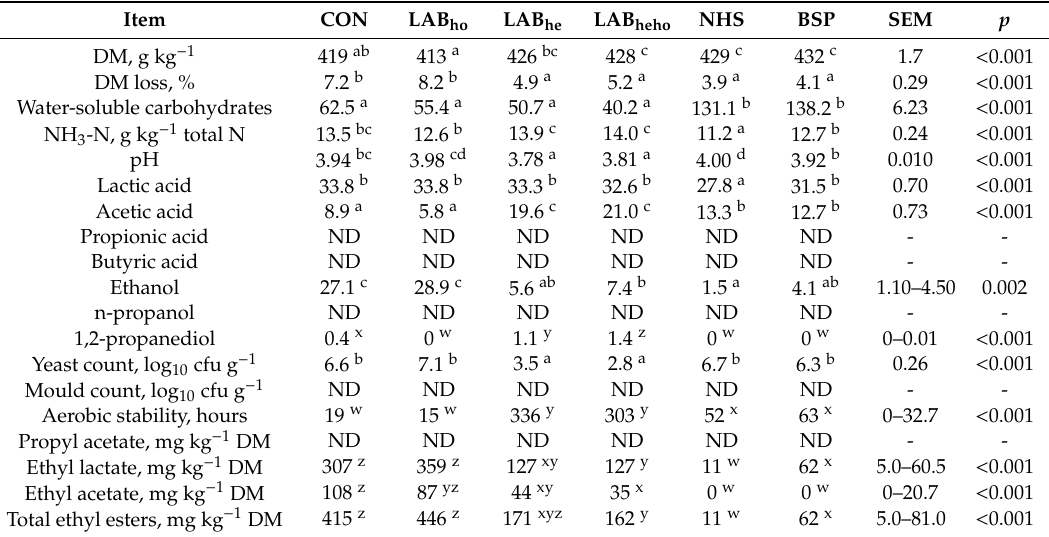
Table 2. E ff ects of the additive type and composition on dry matter (DM) losses, fermentation characteristics, fungal populations and ester concentrations of whole-crop rye silage stored for 53 days (data presented as LS means in g kg − 1 DM unless stated otherwise, n =